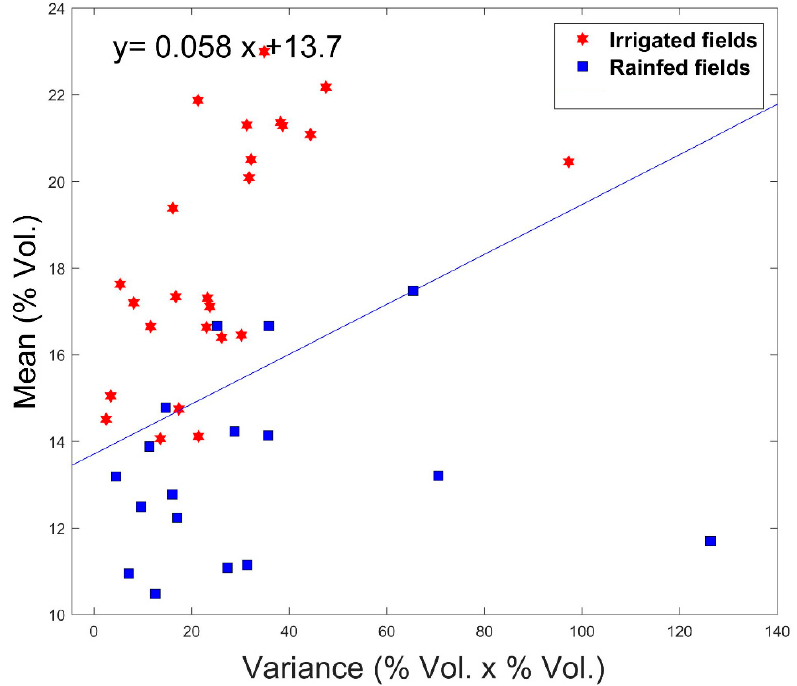
Figure 3. SVM classification using mean values of soil moisture as a function of soil moisture variance, for irrigated and rainfed areas (calibration data set).